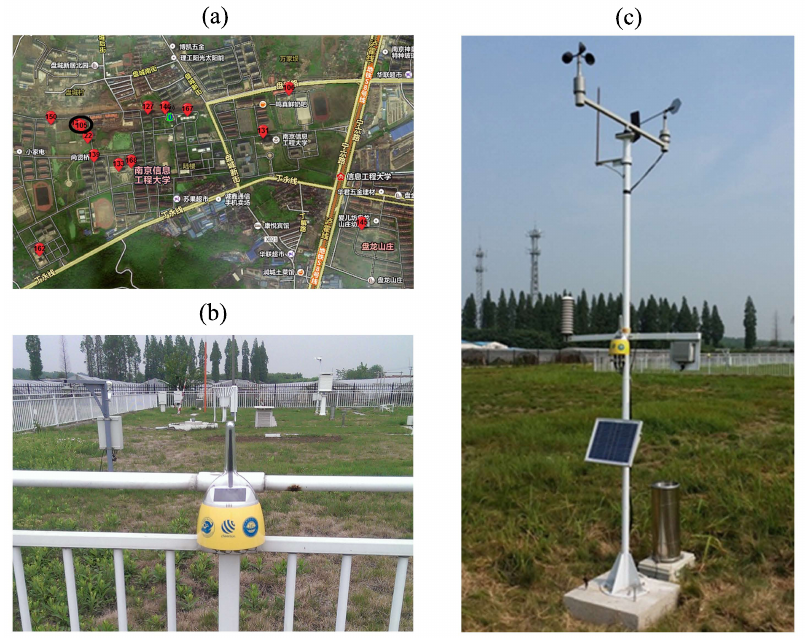
Figure 5. Sensing nodes and the deployment at NUIST. ( a ) The state of the nodes’ deployment; ( b ) a sensing node collecting AT through the on-board sensor; ( c ) a sensing node connected to several meteorological